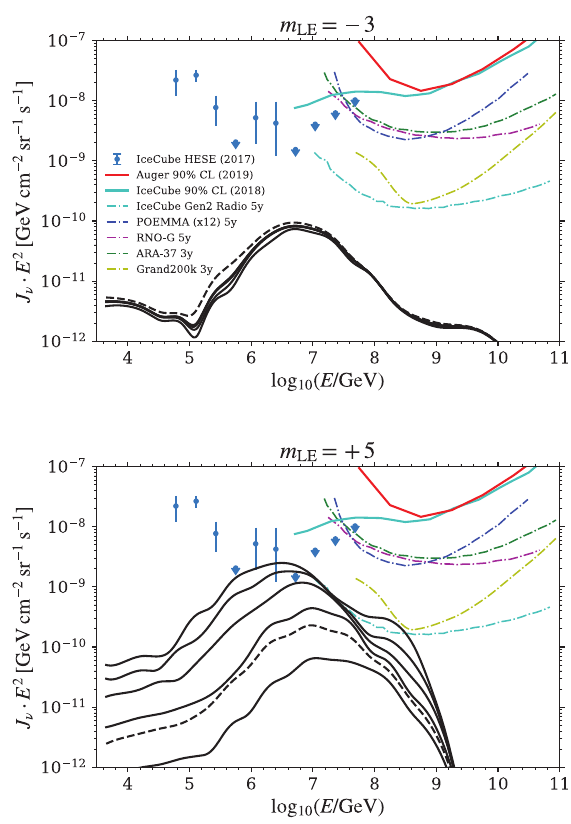
Figure 6. The predicted fluxes of neutrinos (single flavour) cor- responding to the best fit results obtained by assuming a source evolution with m = − 3 (top) and m = 5 (bottom) for the LE com- ponent; the HE component has no source evolution ( m = 0). The observed IceCube HESE flux, the current upper limits from Ice- Cube and Auger (solid lines), and the predicted sensitivities of future detectors (dot-dashed lines) are also shown for reference.